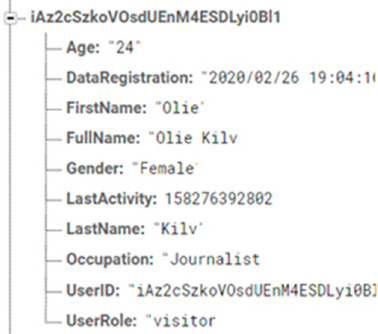
Figure 4. ARtful mobile app’s technological framework.